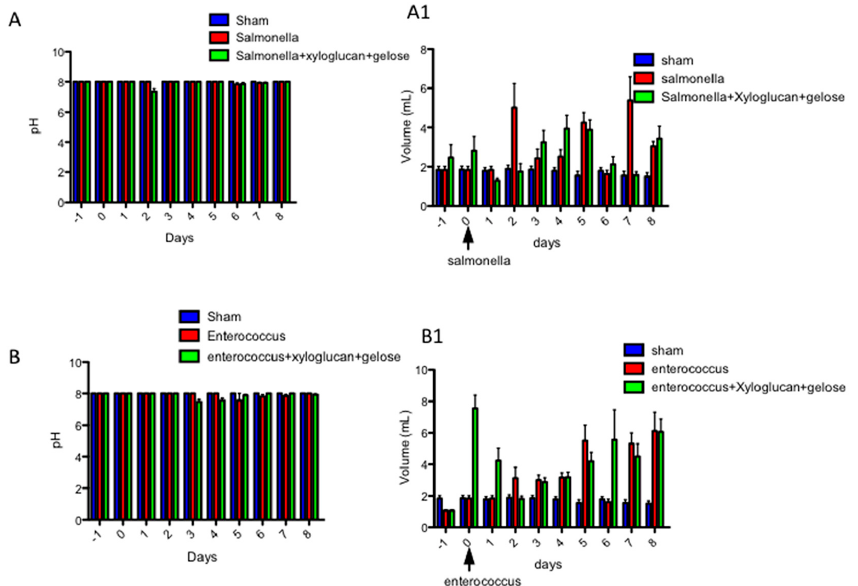
Figure 6. ( A , B ) Urinary pH values were recorded every day for eight days; and ( A1 , B1 ) Urine volume